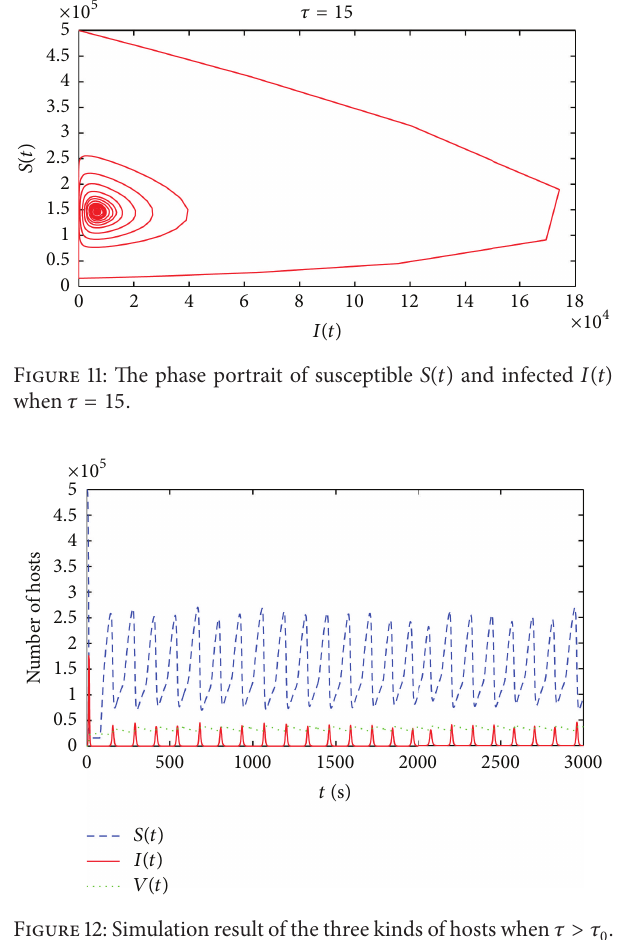
Figure 13: The comparison of numerical and simulation experi-